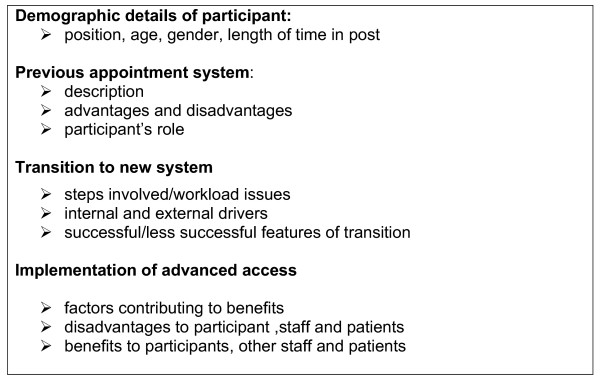
Interview schedule.